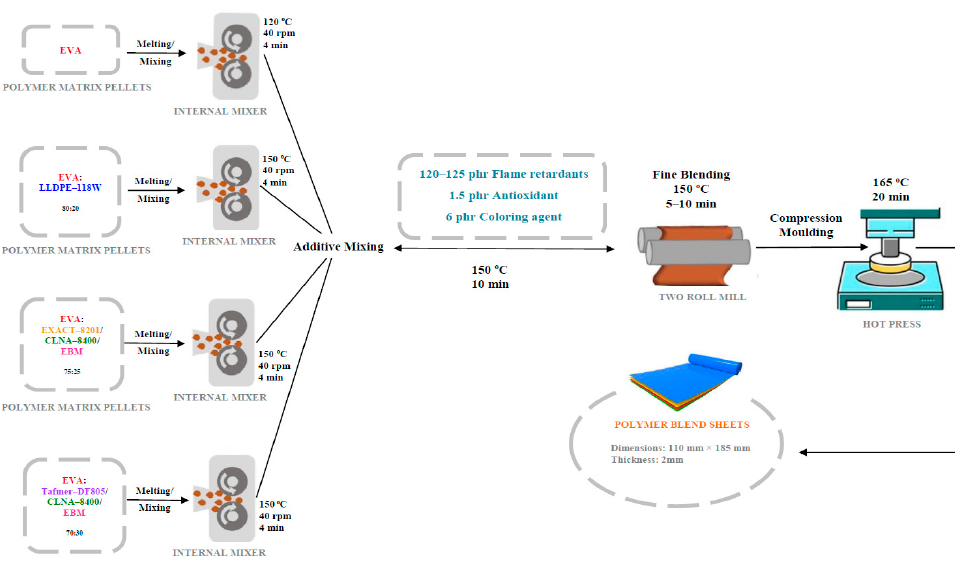
Figure 21. The schematic diagram of the preparation method of